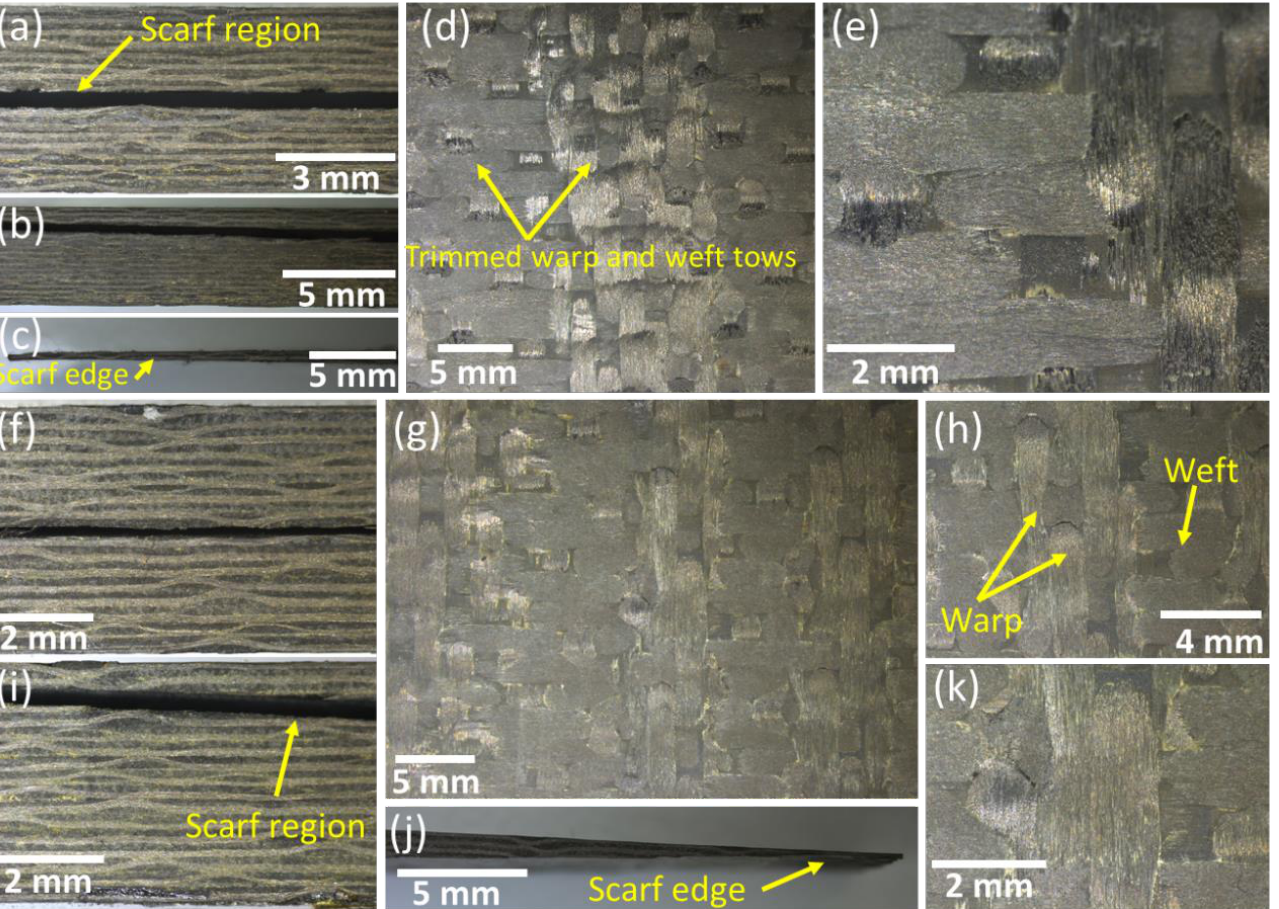
Figure 4. Optical micrographs of the scarf geometries ( a – e ) Type A and ( f – k ) Type B.